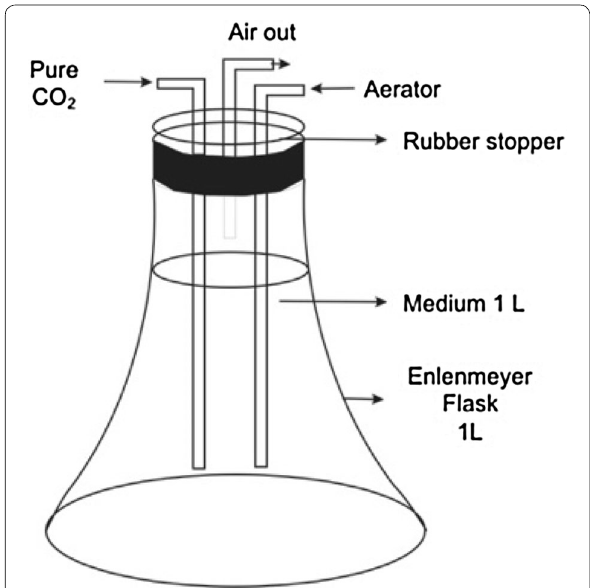
Fig. 2 Treatment of variation in aeration fluid CO 2 concentration 0; 2; 4; 6; and 8% and aeration diagrams